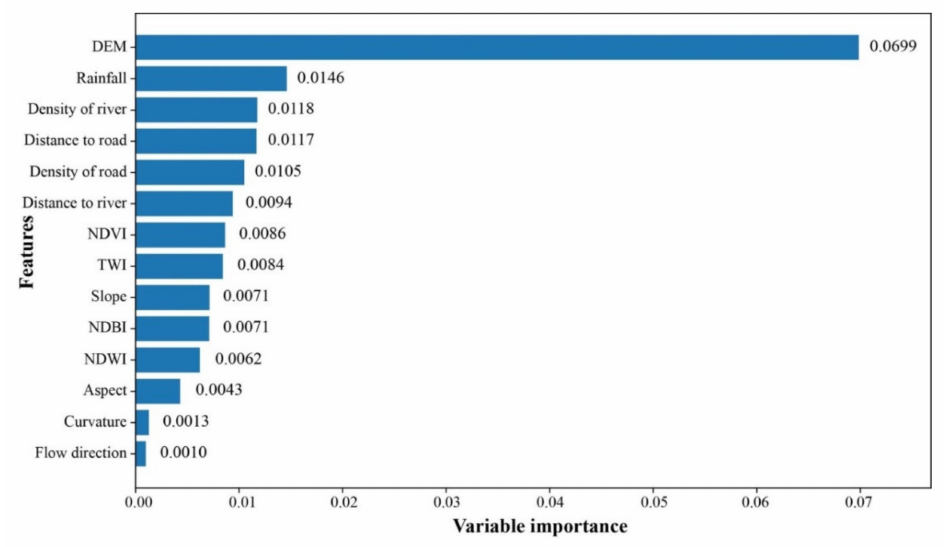
Figure 4. Variable importance using Random